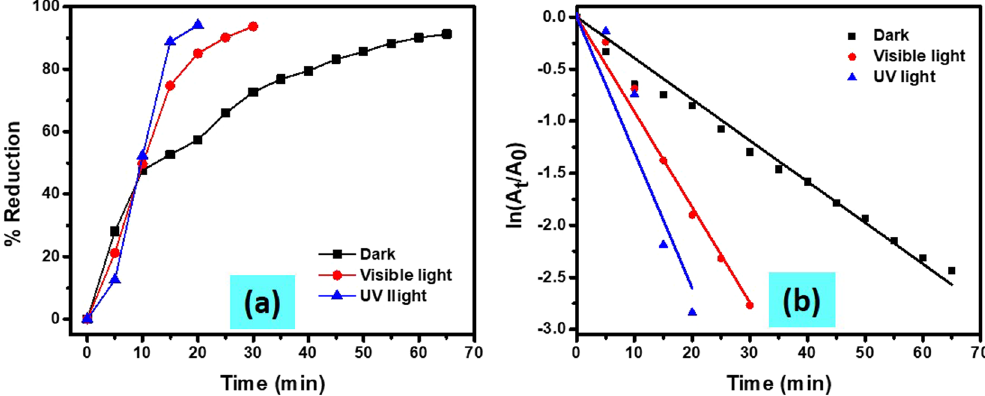
Figure 7. Percent reduction of MO by NaBH 4 as a function of time by using catalyst (Cu/CS-TiO 2 -15) in presence and absence of visible light and UV-radiation ( a ). And their respective Ln (A t /A 0 ) values vs time ( b